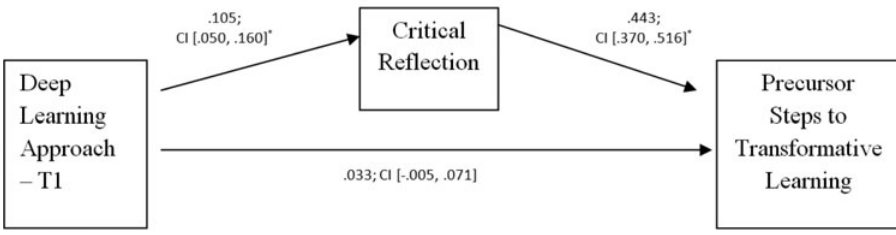
The mediating role of critical reflection in the effect of learning approach on precursor steps to transformative learning. ∗ p <